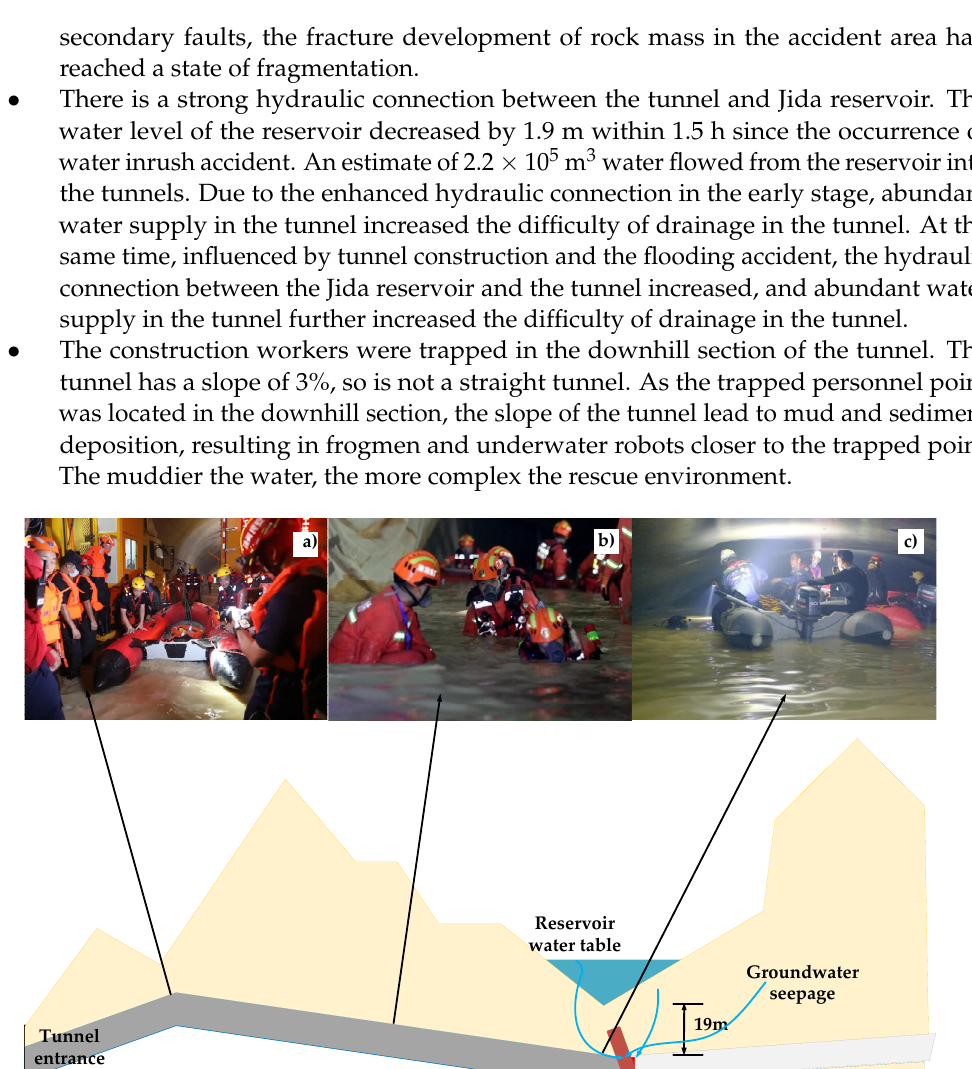
Figure 3. Rescue workers are laying out pumping equipment (Picture from: https://www.guan- cha.cn/politics/2021_07_17_598831_s.shtml, accessed on 18 January 2022) • The rock was already broken, so strong grouting was needed during the rescue to ensure the safety of people at the rescue operation surface. After the water was drained, the soil was backfilled in the surface pit, and the mechanical equipment working face was created by leveling and compaction. Figure 4 depicts the rescue site of reservoir above tunnel. Then, the all-in-one machine drilled and fully spread, and the double-liquid grouting technology was adopted to reinforce the backfilled soil and the face of the tunnel. The double slurry can be solidified within 30 to 50 s, so that the backfill soil can be solidified and compacted quickly, subsequently, the